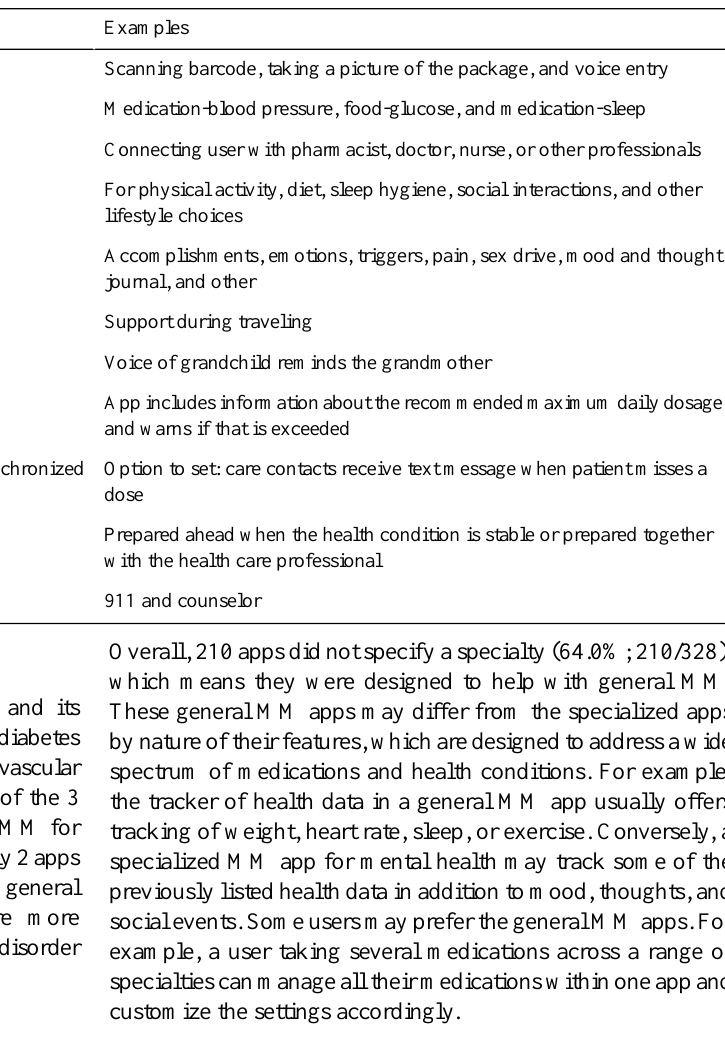
Number of apps that have the featureFeatures